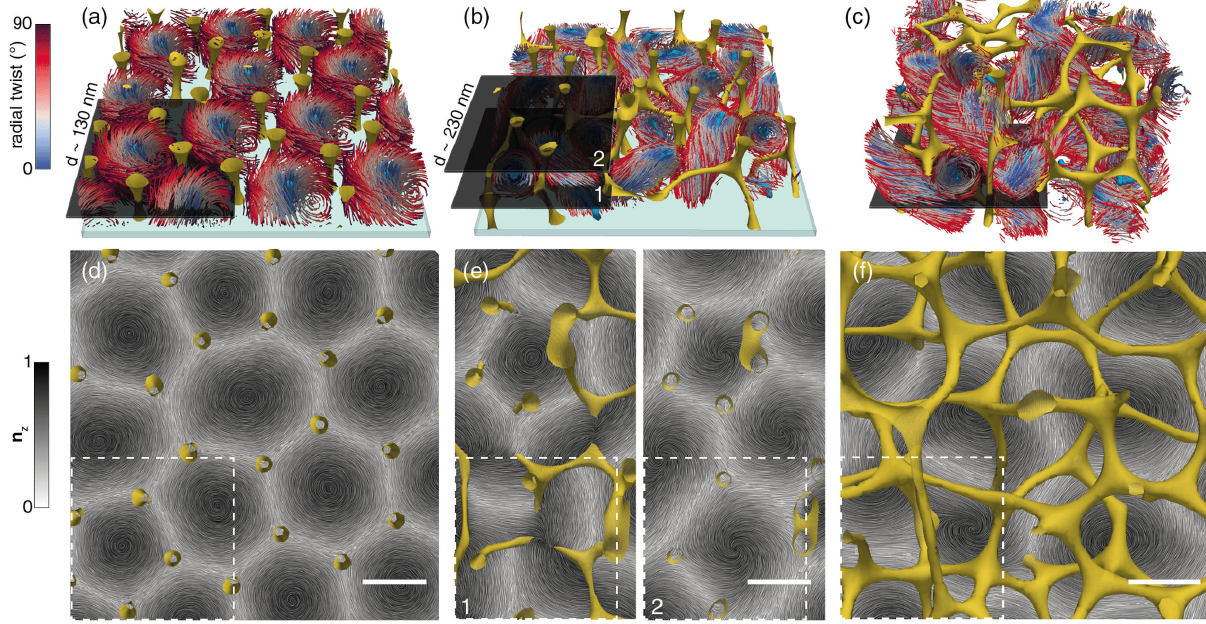
FIG. 10. Director field in BPIII skyrmion structures. (a) The simulated director structure of half-skyrmions in an approximately 130- nm-thin BPIII layer. Colored light blue is the bottom glass plate of the cell. The upper glass plate is not shown for clarity. (b) The simulated director structure of skyrmions in an approximately 230-nm-thick layer. (c) The simulated director structure of skyrmions in bulk BPIII. BPIII skyrmions are visualized using vector field lines colored according to the local radial twist with respect to the center of the skyrmion. The color bar for the radial twist is shown on the left. (d) The director field in the cross section marked by the dark plane in (a), which is located at the center of the cell. The dashed box corresponds to the dark plane in (a). (e)(1) shows the skyrmion director structure in the middle of an approximately 230-nm-thick BPIII layer shown in (b), marked by dark plane 1. The dashed box corresponds to dark plane 1 in (b). (e)(2) shows the director at the interface to the upper glass in (b), marked by dark plane 2. The dashed box corresponds to dark plane 2 in (b). (f) Director field in bulk BPIII, indicated by the dark plane in (c). The dashed box corresponds to the dark plane in (c). The director field in (d) – (f) is shown with streamlines, colored black, where the director points out of plane and white, when it is in plane in accordance with the color bar on the left. In all images, the singular disclination lines are shown in yellow. Scale bars correspond to 100